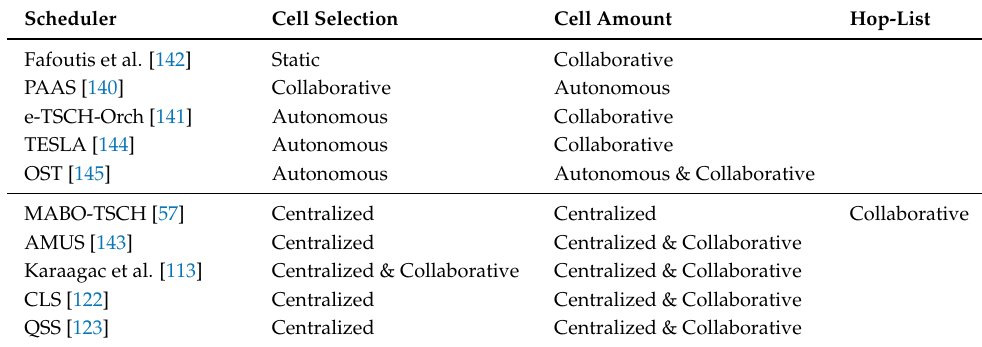
Table 9. Overview of components in hybrid TSCH schedulers.